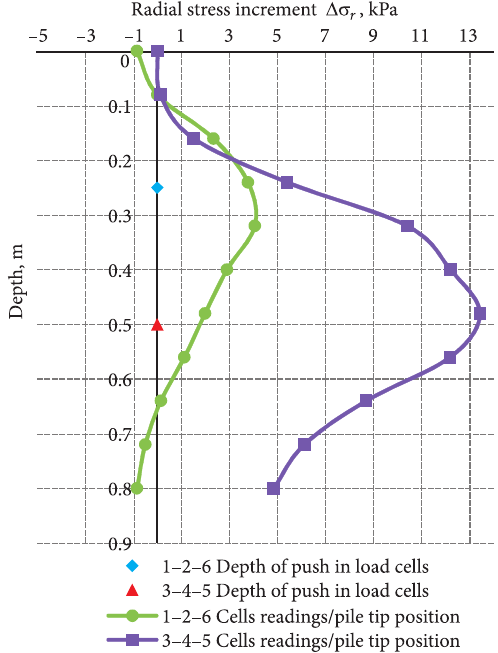
fig. 15. Results of 2 nd model pile test when pile push in was being performed up to 0.8 m depth